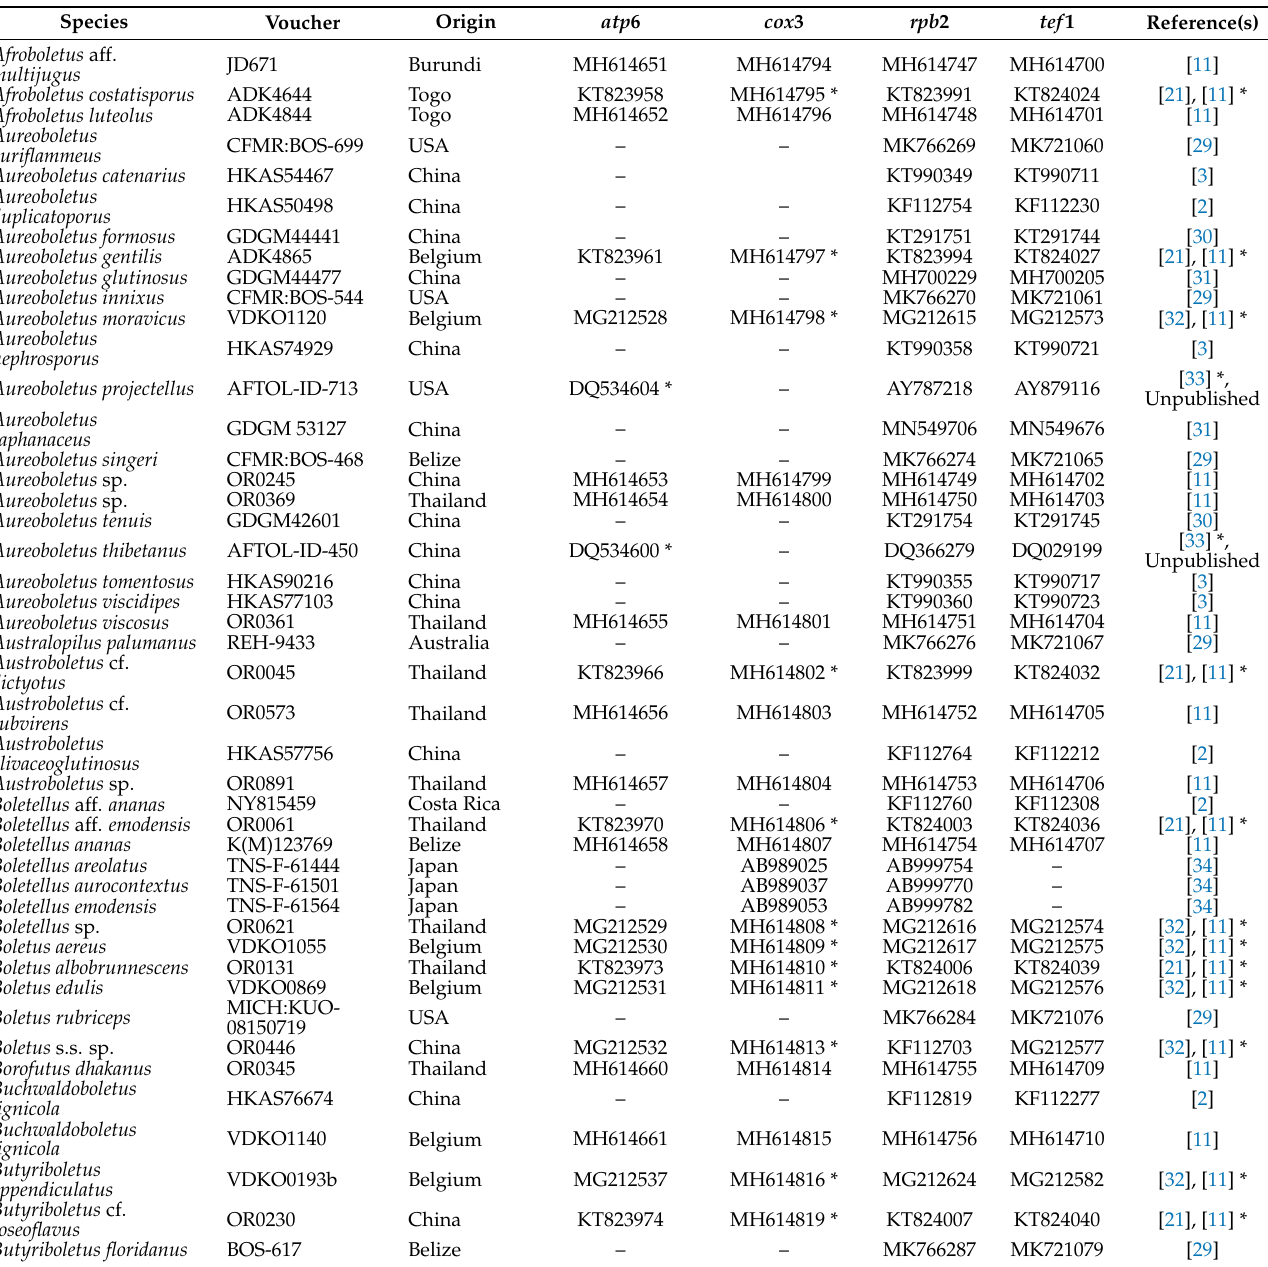
(Figure 1) retrieved the six subfamily clades, namely Austroboletoideae (BS = 99% and PP = 1), Boletoideae (BS = 54% and PP = 0.93), Chalciporoideae (BS = 100% and PP = 1), Leccinoideae (BS = 99% and PP = 1), Xerocomoideae (BS = 99% and PP = 1), and Zan- gioideae (BS = 100% and PP = 1). The Pulveroboletus group of Wu et al. [2,3] was not mono- phyletic, like in previously published phylogenies. However, the monophyly of each genus in this group was highly supported. The selected Rubinosporus auriporus speci- mens were monophyletic (BS = 100% and PP = 1) and clustered in the highly supported Xerocomoideae clade. Table 1. List of collections used for phylogenetic analyses, with origin, GenBank accession numbers, and